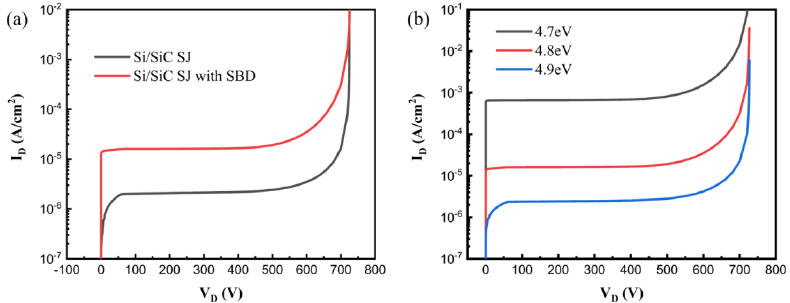
Figure 2. ( a ) Shows the forward blocking I-V characteristics at V gs = 0 V and ( b ) Shows the forward blocking I-V characteristics of Si/SiC SJ with SBD with the different work functions of the source1 metal at V gs = 0 V.